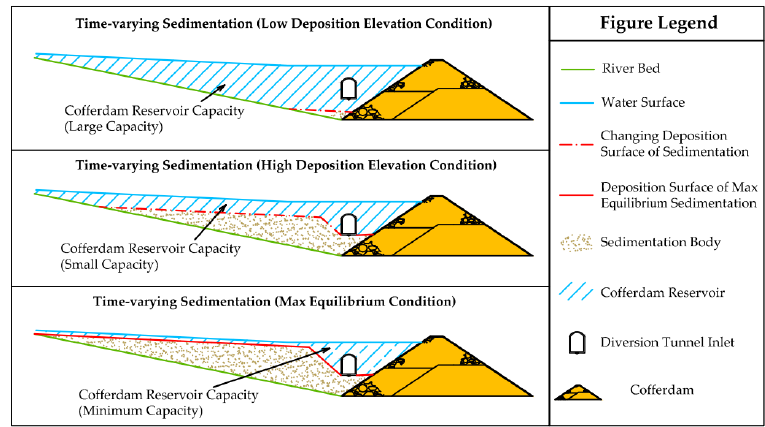
Figure 4. Conditions of time-varying sedimentation and Cofferdam Reservoir Capacity.